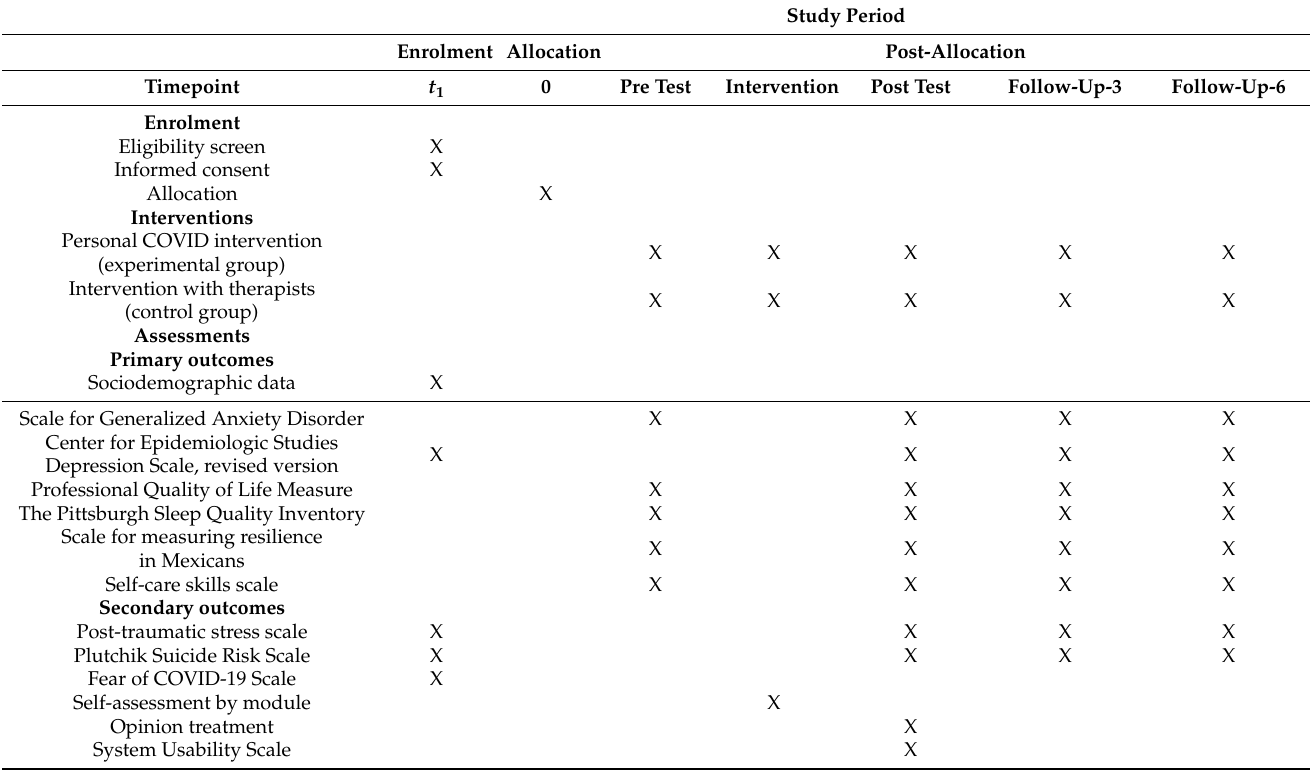
Table 1. Schedule of enrolment, interventions, and assessments according to the SPIRIT